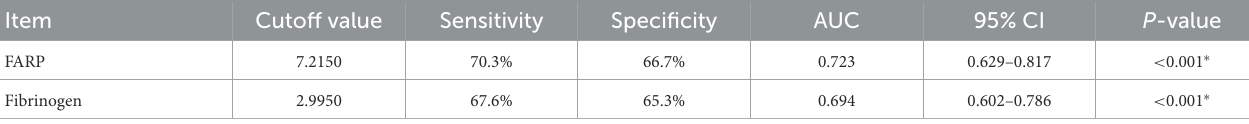
TABLE 9 ROC curve analysis of the prediction of disease prognosis based on FARP. Item